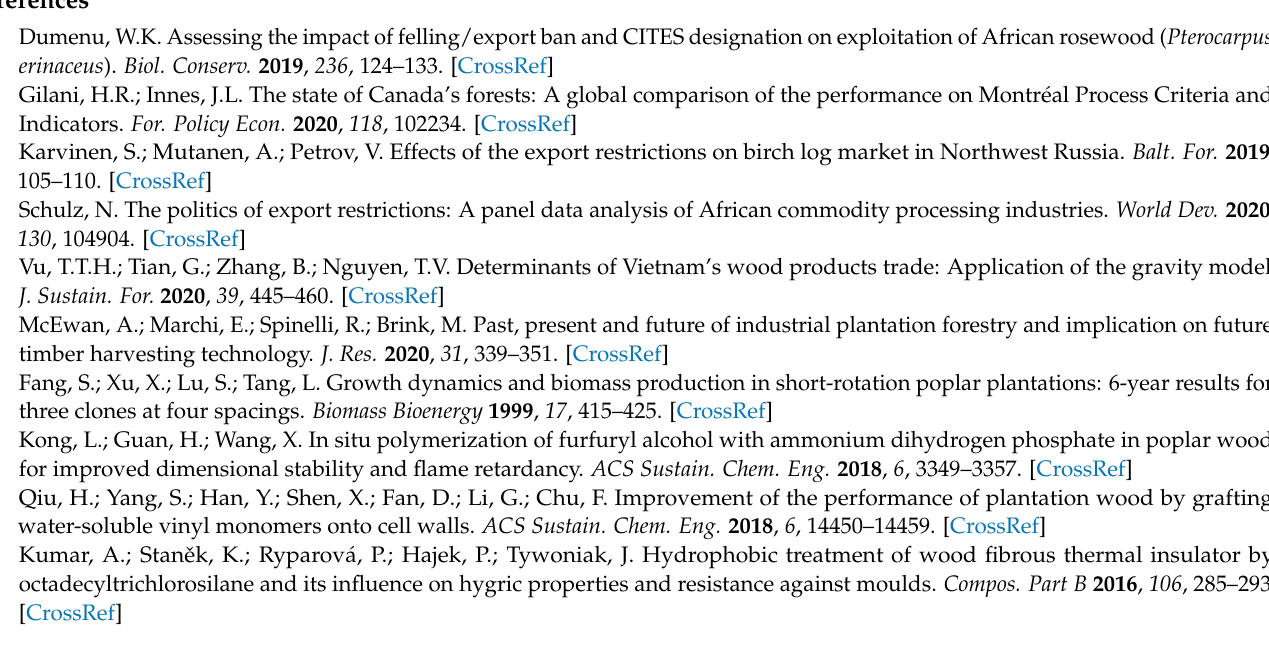
Figure 4. Relative pore volume of modified wood with different weight gain percent (WPG) (0%, 23% and 69%), ( a ) measured by MIP; ( b ) measured by NMR cryoporometry. Unlike furfurylation, wax with lumina filling was only involved in a part of macropores because cell walls, resin canals, rays and axial parenchyma were difficult to wax impregnation [50,51]. Pores with the diameters less than 30 nm remarkably increased after dimethyloldihydroxyethyleneurea (DMDHEU) treatment [45]. This increase was in